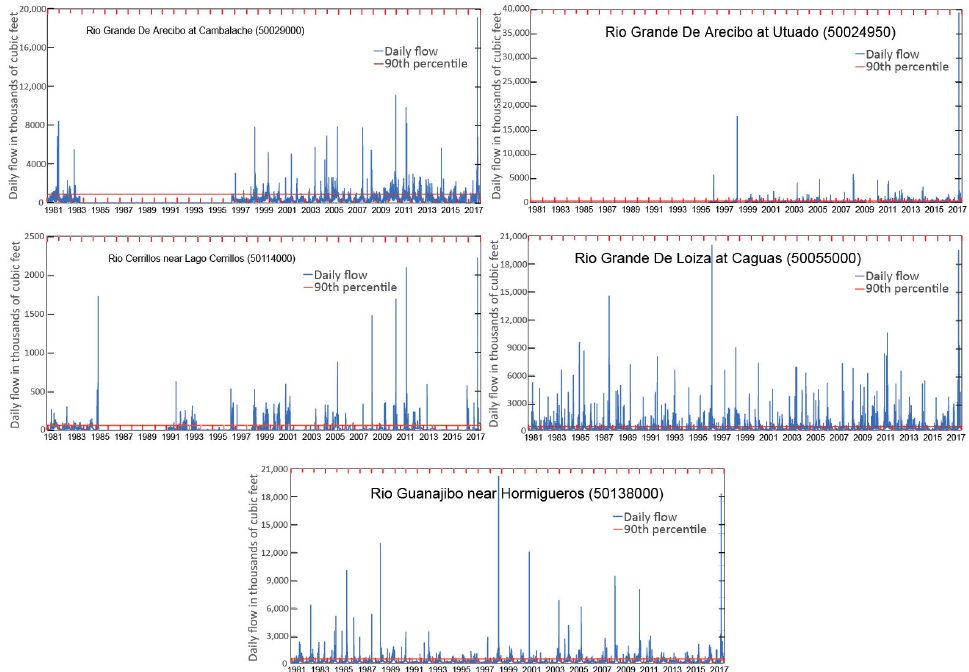
Figure 7. Observed daily flows at field stations and lower 90th percentile of observed daily flows.